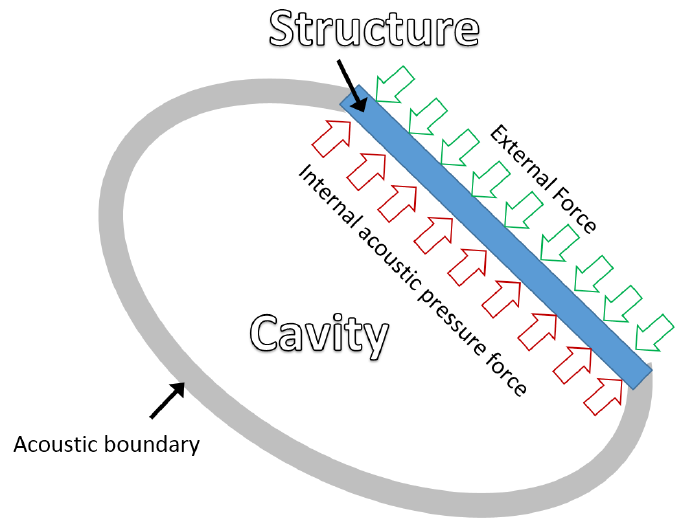
Figure 2. General concept of a structural–acoustic model.